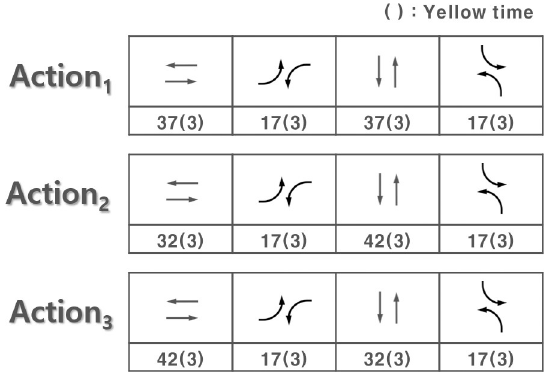
Fig 3. Three predetermined signal timing plan list as